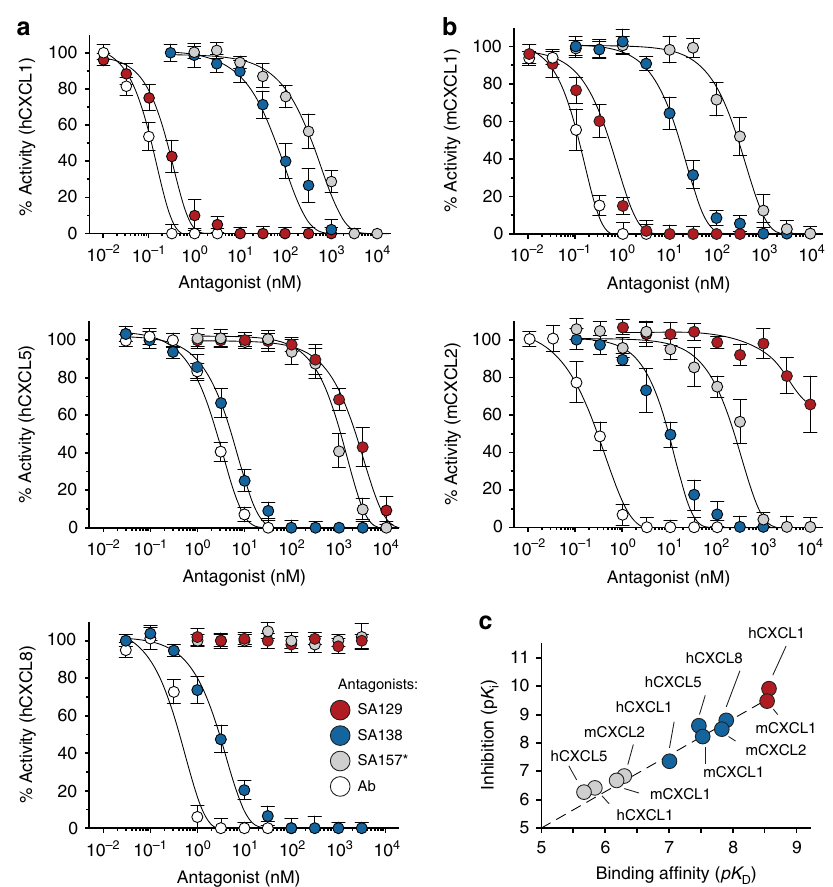
Fig. 6 Crossreactive antibodies inhibit ELR + CXC chemokine signaling in vitro. Residual activity of a human hCXCL1, hCXCL5, and hCXCL8 and b mouse mCXCL1 and mCXCL2 chemokines incubated with varying concentrations of SA129 (red), SA138 (blue), and SA157* (gray) fusions, and commercial neutralizing antibodies (Ab, white). The indicated values are the means of three independent experiments. c Plot displaying p K i versus the calculated p K D of SA129 (red), SA138 (blue), and SA157* (gray) fusions. Data are presented as mean (dots)± s.e.m.